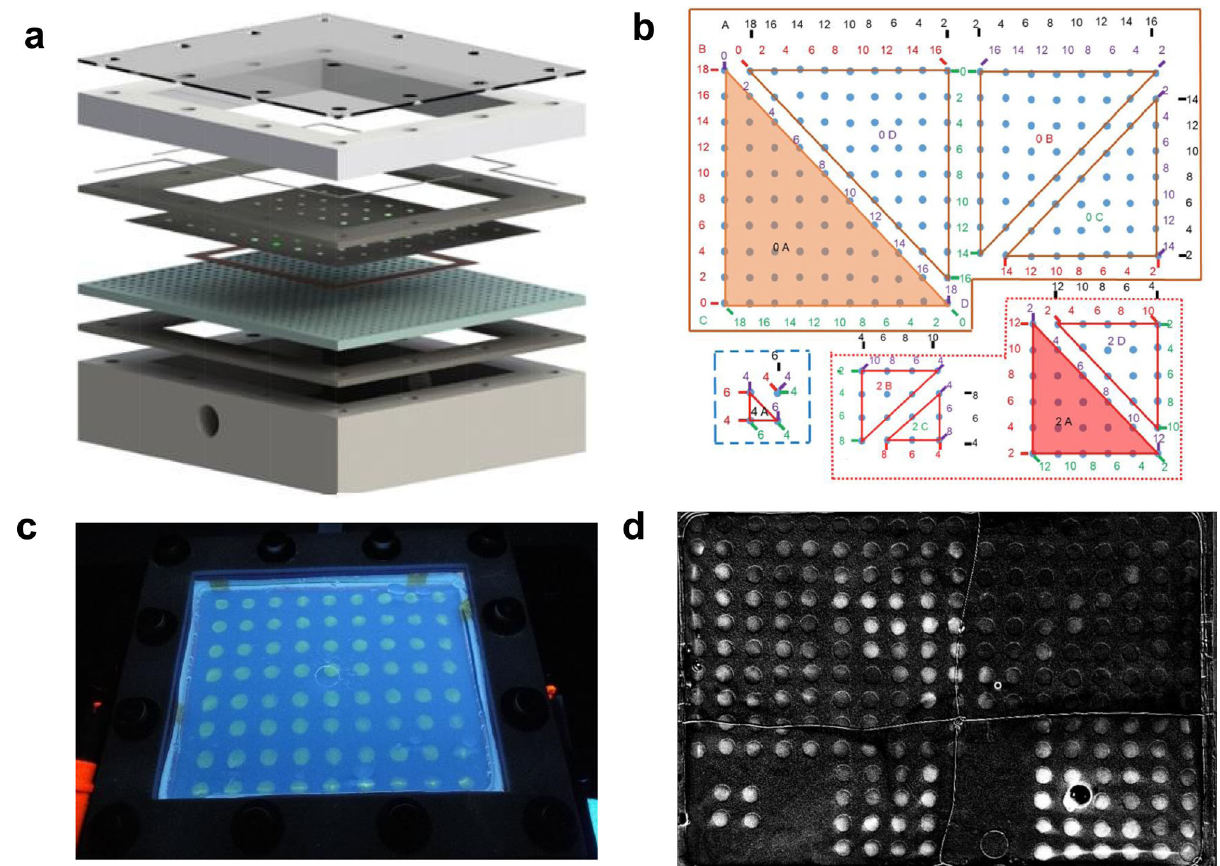
Fig. 1 Screening cell. a Exploded view of the electrochemical screening cell. Pt and Ag wires are used as the counter and reference electrodes, respectively. A Cu current collector is beneath the array working electrode. The cell sandwiched between silicone gaskets and isolated from air. b Mapping of a four- component composition space (220 discrete compositions). c Color image showing the fl uorescence pattern from a uniform grid of Pt catalyst spots. d CO 2 RR fl uorescence image of a four-component electrocatalyst